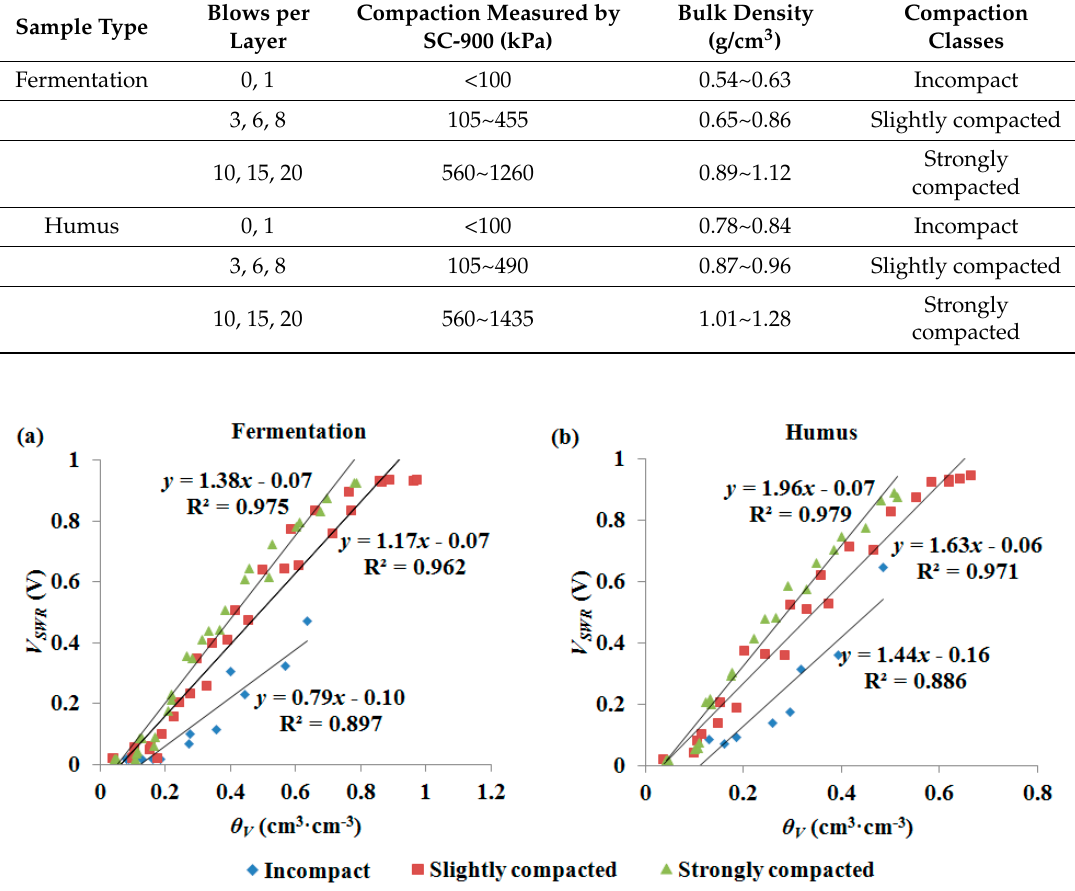
Figure 5. Volumetric water content determined gravimetrically ( θ V ) vs. SWR output voltage ( V SWR ) for the samples of fermentation ( a ) and humus ( b ) in different compaction classes.